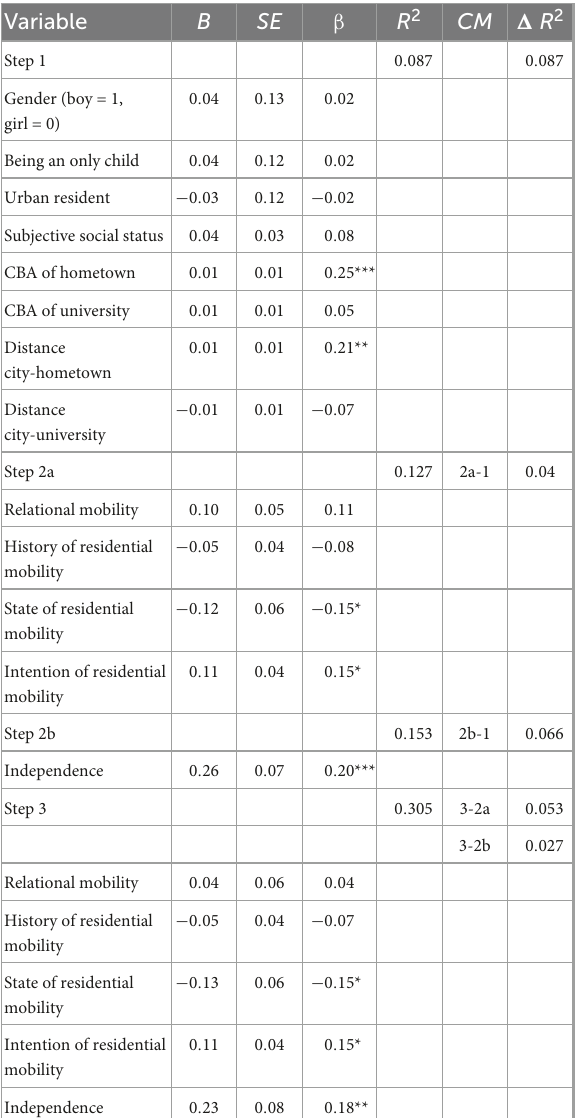
TABLE 2 Results of hierarchical regression analyses for dependence, mobility, and other covariates predicting preference for cosmopolitan cities (the first preferred